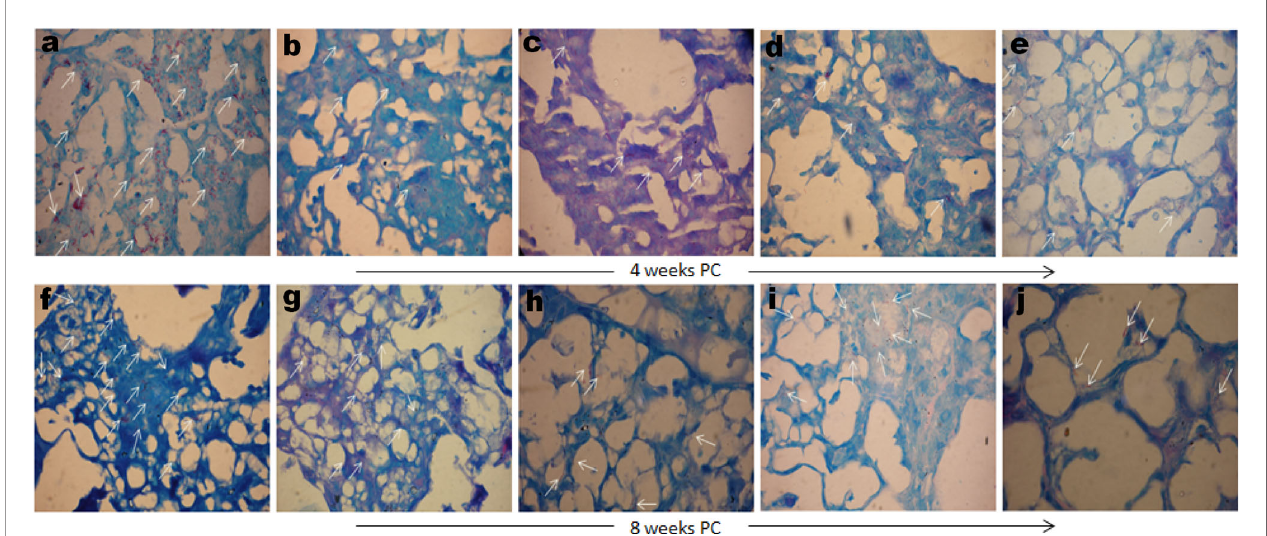
FIGURE 11 | Gross tissue mycobacterial loads in the infected lungs. Representative photomicrographs showing differential Mtb bacillary loads in the lungs tissue sections of immunized and DPP immunotherapy administered animals at 4 (upper panel) and 8 (lower panel) weeks PC. Arrows indicating Ziehl – Neelsen dye stained Mtb bacilli in various immunized and treated groups (Original magni fi cation — 1000× in oil immersion lamp). The various groups were as follows: (A, F) Saline (B, G) BCG (C, H) rBCG30, (D, I) rBCG30+PVI, and (E, J) rBCG30+PII,